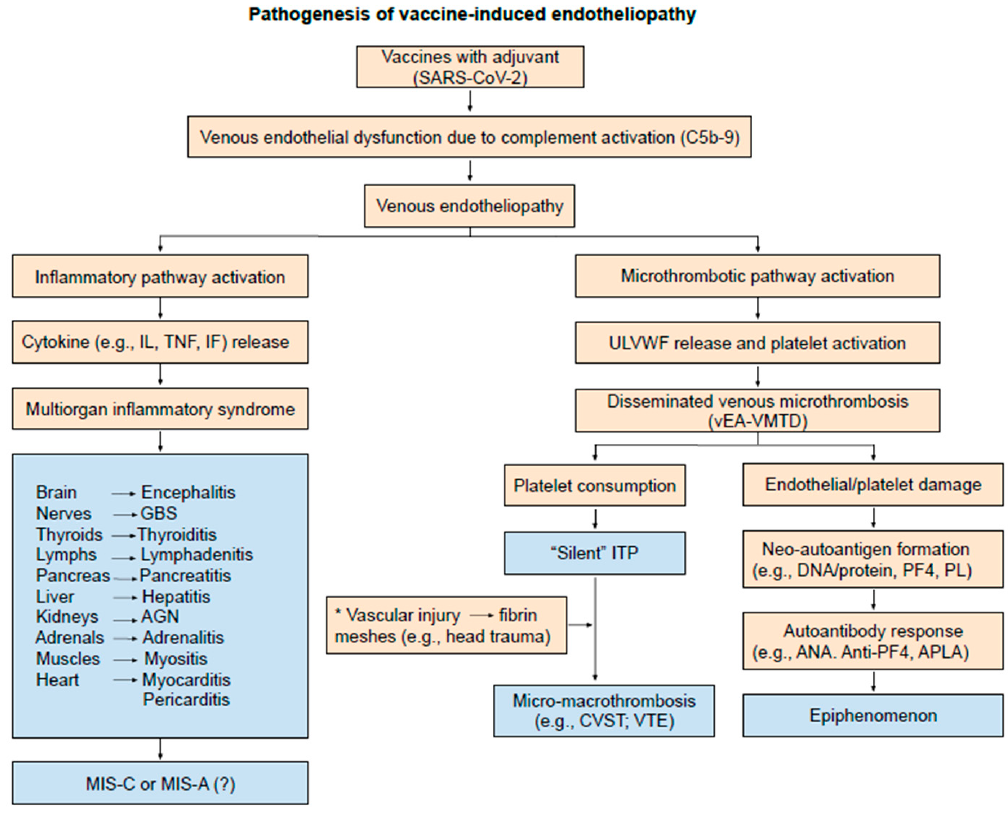
Figure 3. Pathogenesis of vaccine-induced endotheliopathy. The venous endothelial pathogenesis in SARS-CoV-2 vaccines is self-explanatory. Compared to aEA-VMTD/vEA-VMTD of sepsis, vEA-VMTD from vaccination does not typically cause MAHA and life-threatening hypoxic MODS. However, it can cause its share of another combined micro-macrothrombotic syndrome, a complex form of DVT, especially CVST as explained in the text. Incidentally, the occurrence of VTE in sepsis and CVST in vaccination provides additional insights in thrombogenesis for the important role of vascular accesses in the hospitalized patient, ICU in particular. Sub-references for observed MOIS shown in Table S1 are available in Supplementary file. Abbreviations: aEA-VMTD, arterial endotheliopathy-associated VMTD; vEA-VMTD, venous EA-VMTD; APLA, antiphospholipid antibodies; PF4, platelet factor 4; PL, phospholipids; CVST, cerebral venous sinus thrombosis; DVT, deep venous thrombosis; ITP, immune thrombocytopenic purpura; MAHA, microangiopathic hemolytic anemia; MIS-C, multisystem inflammatory syndrome in children; MIS-A, MIS in adults; MODS, multiorgan dysfunction syndrome; MOIS, multiorgan inflammatory syndrome; VTE, venous thromboembolism; AGN, acute glomerulonephritis; GBS, Guillain-Barre syndrome: IF, interferon, IL, interleukin; TNF, tumor necrosis